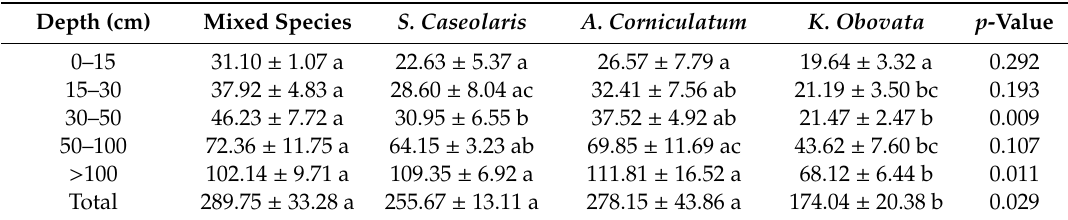
Table 3. Soil carbon pools (mean ± SE) (Mg / ha) according to mangrove species in the study area. The letters in each row denote the di ff erences among species.